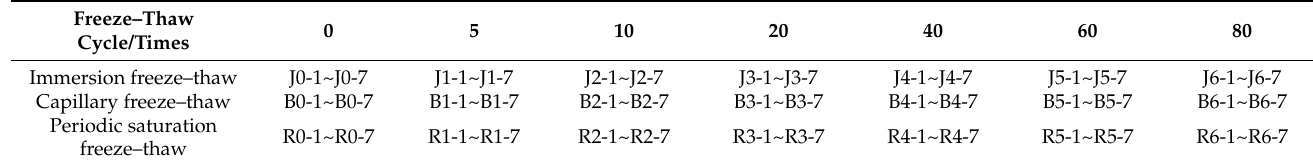
Table 1. Grouping of rock samples with different freeze – thaw modes.